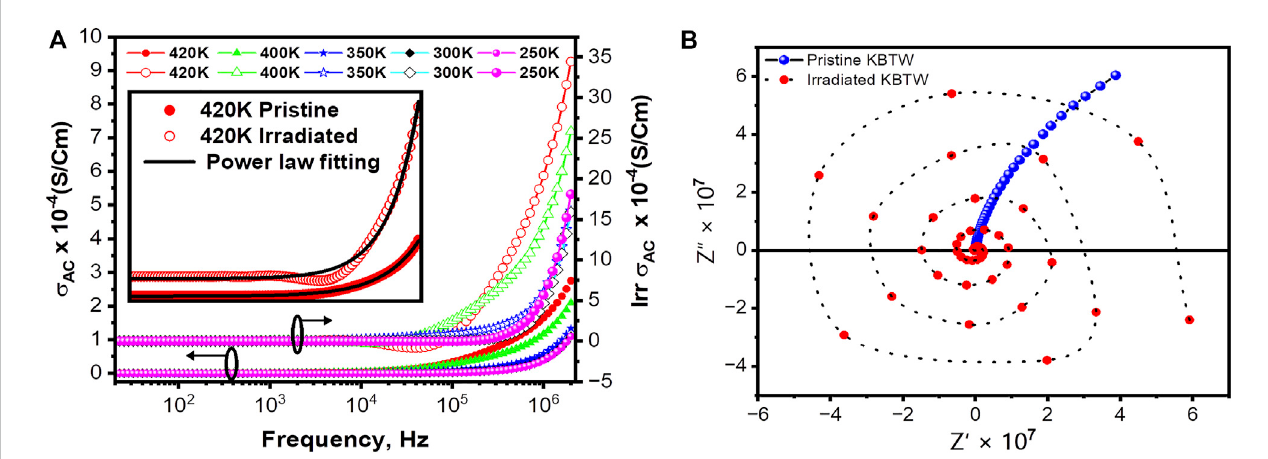
FIGURE 5 (A) The frequency dependence of conductivity for pristine and irradiated KBTW. The inset shows the deviation from Johncher ’ s law post irradiation. (B) The Comparative Nyquist plot in case of pristine and irradiated KBTW. The irradiated sample shows a spiral curve suggesting strong inductive effects at lower